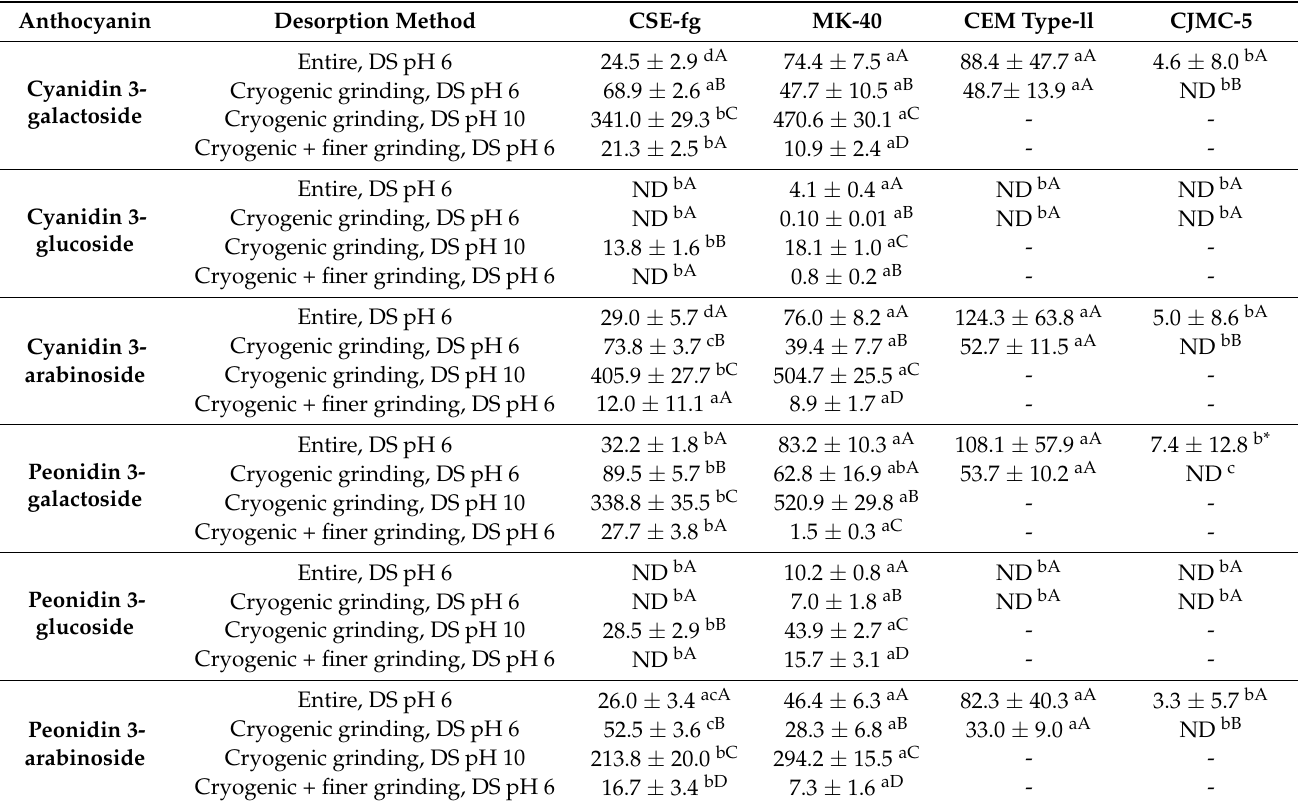
Table 8. Anthocyanin content of desorption solutions (DS) ( µ g anthocyanin/cm3 membrane). Anthocyanin